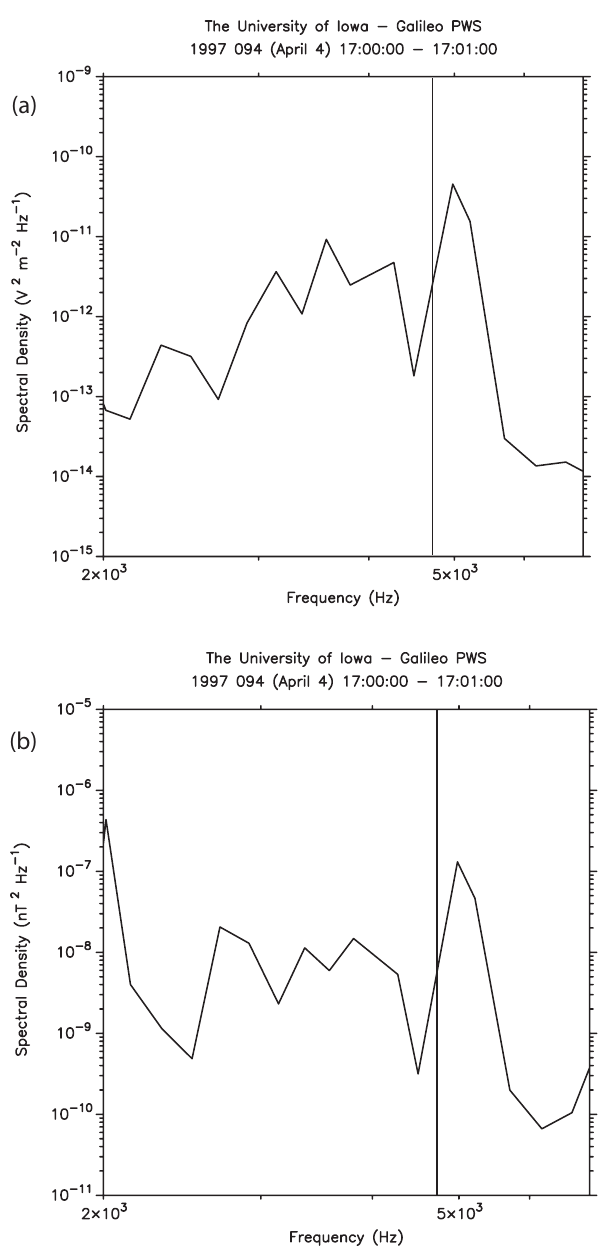
Fig. 3. The average spectral density versus frequency in the range 2kHz to 7kHz for the one-minute time interval 17:00 to 17:01UT. The electric and magnetic spectral densities are displayed in (a) and (b) , respectively. The vertical lines of panels (a), (b) indicate the location of f ce /2 based on the average value of the magnetic field during the one minute time interval.